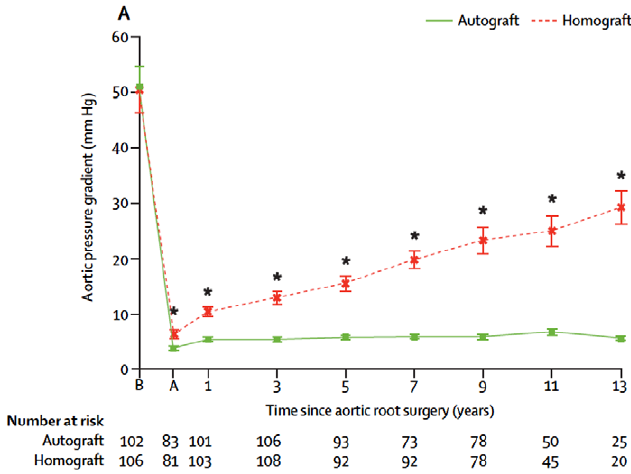
Figure. 15 Algorithm for the interpretation of high transprosthetic gradient. DVI: Doppler velocity index; EOA: effectiveorificearea;IEOA:indexedEOA;TEE:Transesophagealechocardiography.(Reproducedwithpermission from